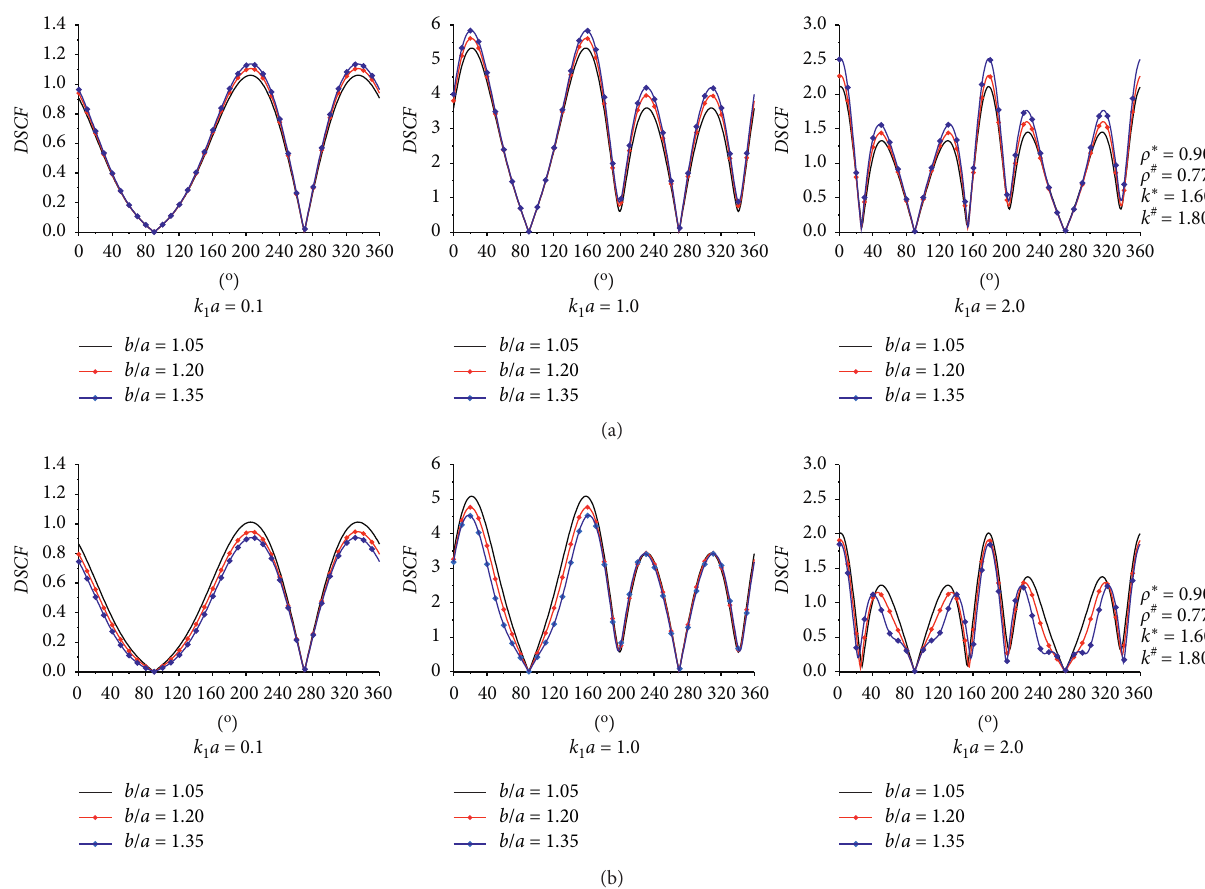
Figure 7: DSCF of linings composed of grade C30 concrete for geological condition A. (a) Condition A-C30: inner surface. (b) Condition A-C30: outer